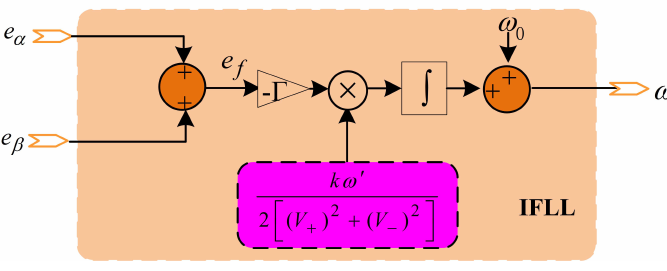
Figure 3. The structure of the